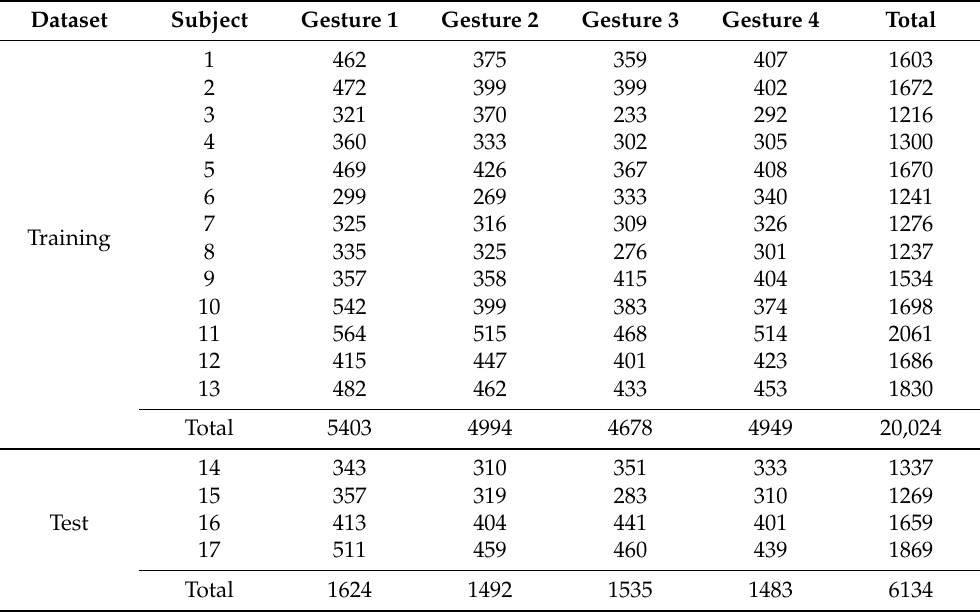
Figure 9. Finger tapping sample frames from PAKH dataset. ( a ) Four hand gestures of finger tapping test in the PAKH dataset, from left to right: right hand with the other three fingers stretched out; right hand with the other three fingers folded onto the palm; left hand with the other three fingers stretched out; left hand with the other three fingers folded onto the palm. ( b ) One complete tapping consisting of an opening phase (frame 1 to 4) and a closing phase (frame 4 to 7). Table 1. The number of frames for each gesture in PAKH in training and testing.